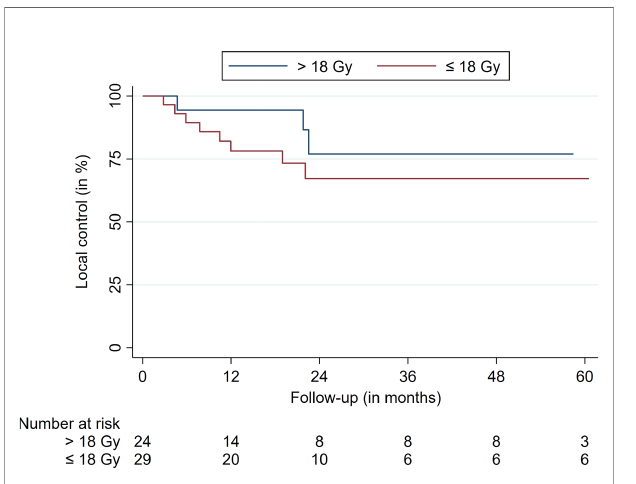
FIGURE 1 | Local control strati fi ed for a prescription dose cutoff at 18 Gy.